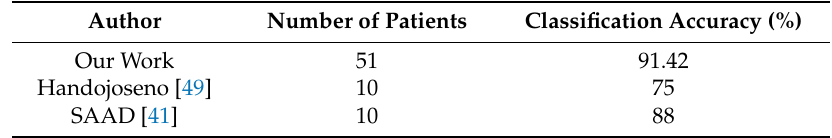
Table 4. Performances of machine-learning-based FoG detection